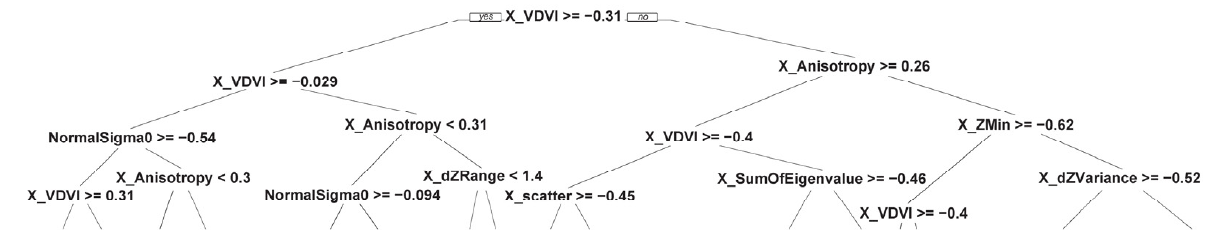
attribute is presented in Figure 22.